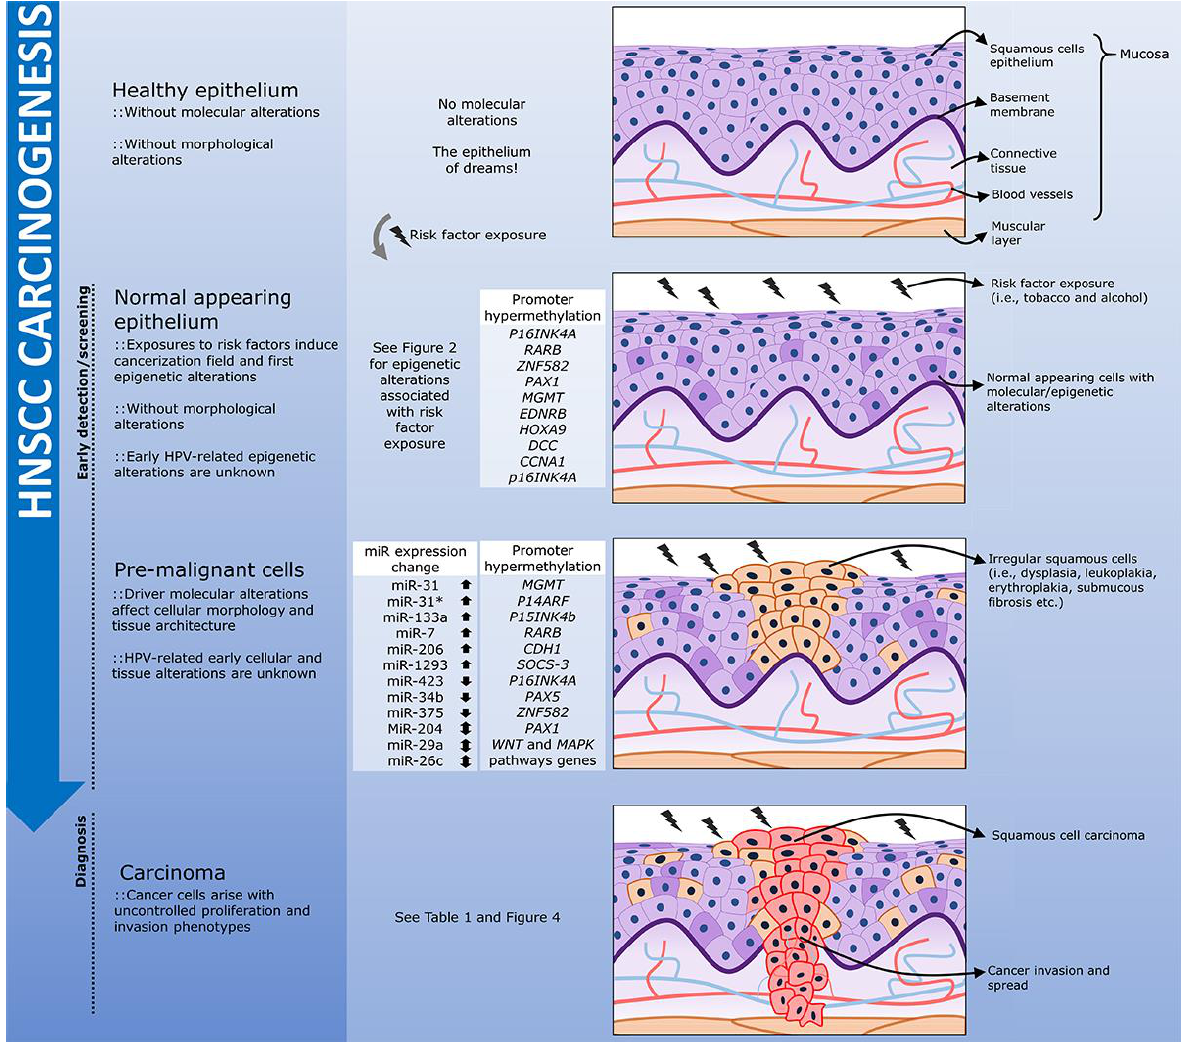
Figure 3. The natural history of HNSCC development through an epigenetic perspective. The exposure of the head and neck healthy epithelium to risk factors, such as tobacco and alcohol, may lead to the accumulation of DNA methylation alterations and miRNA aberrant expression even before the first morphological changes are observed. This characterizes a molecular cancerization field that may favor the development of pre-malignant lesions. In head and neck, the presence of leukoplakias and erythroplakias, frequently associated with dysplasia, increases the risk of tumor development, and these lesions are characterized by specific epigenetic alterations. The epigenetic aberrations observed in both the cancerization field and in the pre-malignant lesions, have the potential to be used as early markers of HNSCC carcinogenesis in screening programs. Finally, tumor onset and progression may be followed by further aberrant DNA methylation and miRNA expression. HPV-positive HNSCC epigenetic natural history is largely